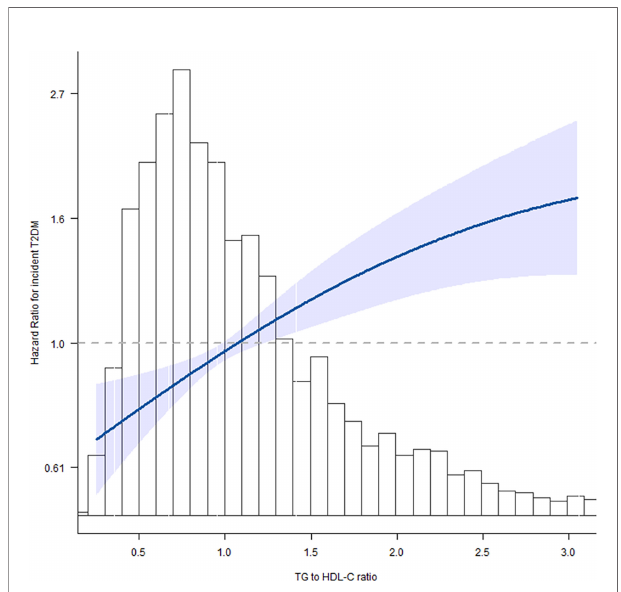
FIGURE 1 | Kaplan – Meier curves depicting the cumulative incident type 2 diabetes mellitus (T2DM) in different quintile groups (Q1 to Q5) of triglyceride to high-density lipoprotein cholesterol ratio. Each color of lines indicates a quintile group. The color range indicates the 95% CI range of cumulative incidence of T2DM at different follow-up times.